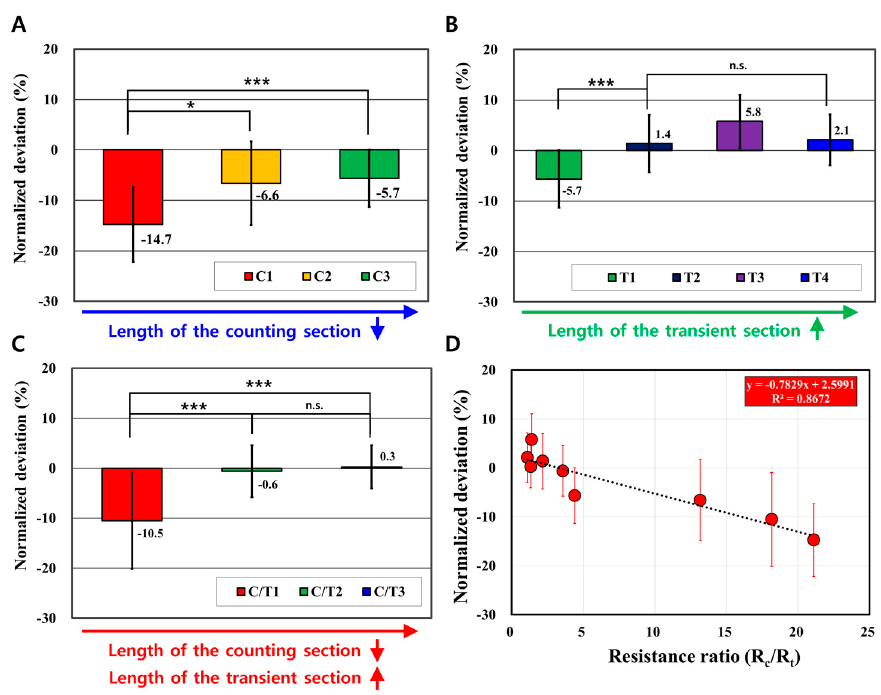
Figure 3. Parametric study for the design optimization of the micro-viscometer. ( A ) At a given length of the transient section (1000 μ m), it is confirmed that, as the length of the counting section is decreased (from C1 to C3), the relative error significantly decreases. (* p < 0.05, *** p < 0.001) Specifically, the underestimation seems to be alleviated because the hydraulic resistance of the counting section, which is related to the Fahraeus effect, is relatively decreased. ( B ) At a given counting section length (500 μ m), it is confirmed that the relative error significantly decreases as the length of the transient section increases (from T1 to T4). This is also caused by the counting section, which has a relatively low value of hydraulic resistance. ( C ) When the length of the counting section is reduced and the length of the transient section is simultaneously increased (from C/T1 to C/T3), the underestimation decreases, and eventually the relative error converges. ( D ) The resistance ratio between the counting and transient sections is expressed as R c / R t , represented as the x-axis in the graph. The underestimation due to the Fahraeus effect occurs as the counting section resistance increases. On the contrary, it is confirmed that an accurate viscosity measurement is possible when the resistance ratio converges to be close to zero (y-intersect: 2.5991%).